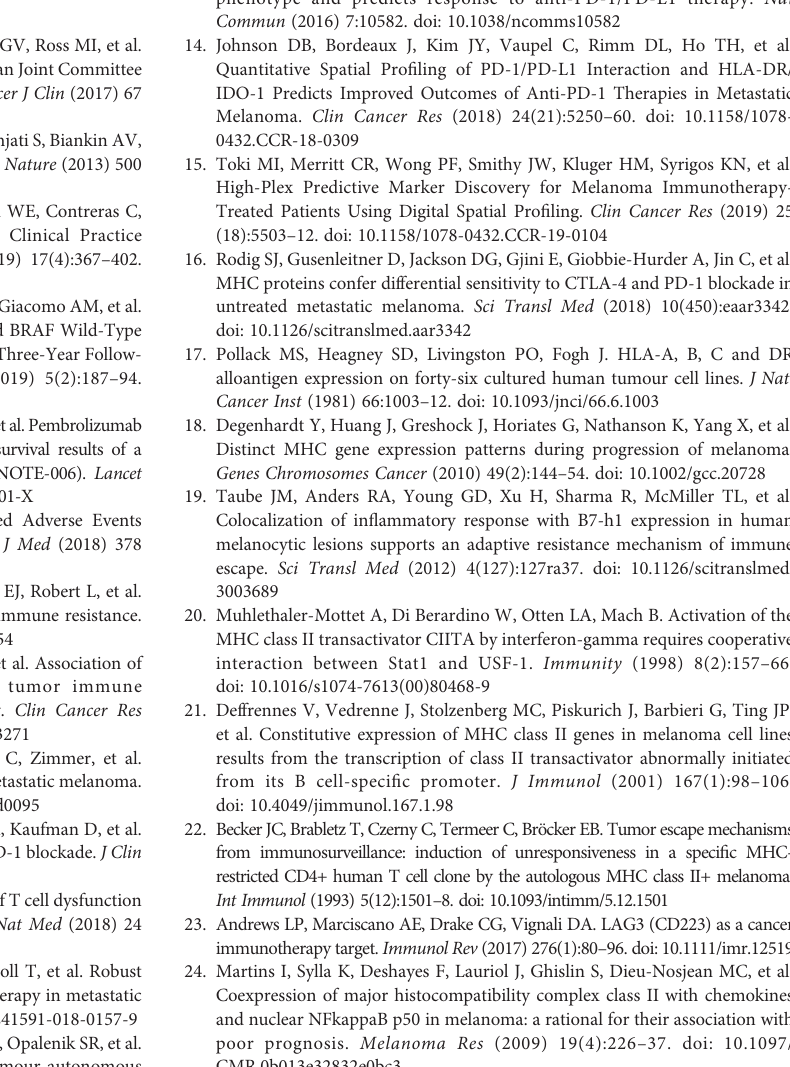
Supplementary Figure 3 | Cell density single cell composition of HLA-DR+ areas, HLA-DR- areas in positive tumours, HLA-DR- tumours, germinal centers and tertiary lymphoid structures. Boxplots indicating the cell density (cells/mm²) of different cell- types in the different micro dissected areas, from left to right: ‘ GC ’ (Germinal centre from reactive lymph nodes; orange), TLS (germinal centers from tertiary lymphoid structures, ochre), ‘ NegTum ’ (Tumour border of HLA-DR negative tumours, green), ‘ NeginPos ’ (HLA-DRnegative area ofHLA-DRpositive tumours,blue) and ‘ Pos ’ (HLA- DR positive area of HLA-DR positive tumours, pink). BC= B cell not further speci fi ed;